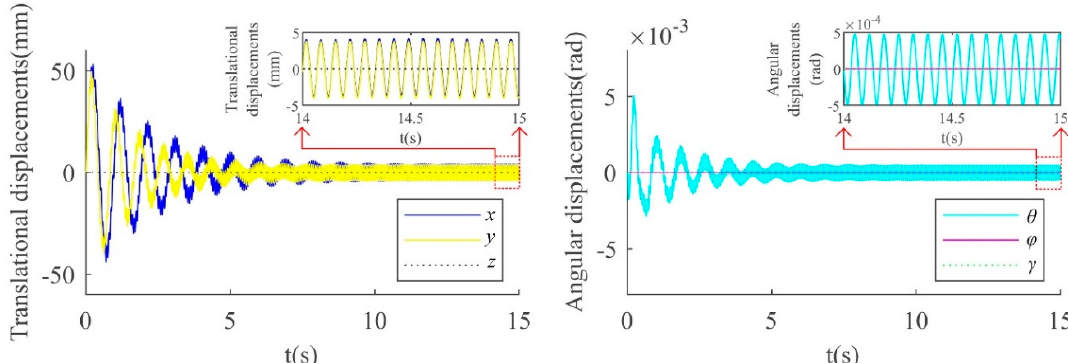
Figure 5. Displacement curves of the mass center under normal conditions, including two translational displacements ( x , y ) and one angular displacement ( θ ). Additionally, z = φ = γ = 0.